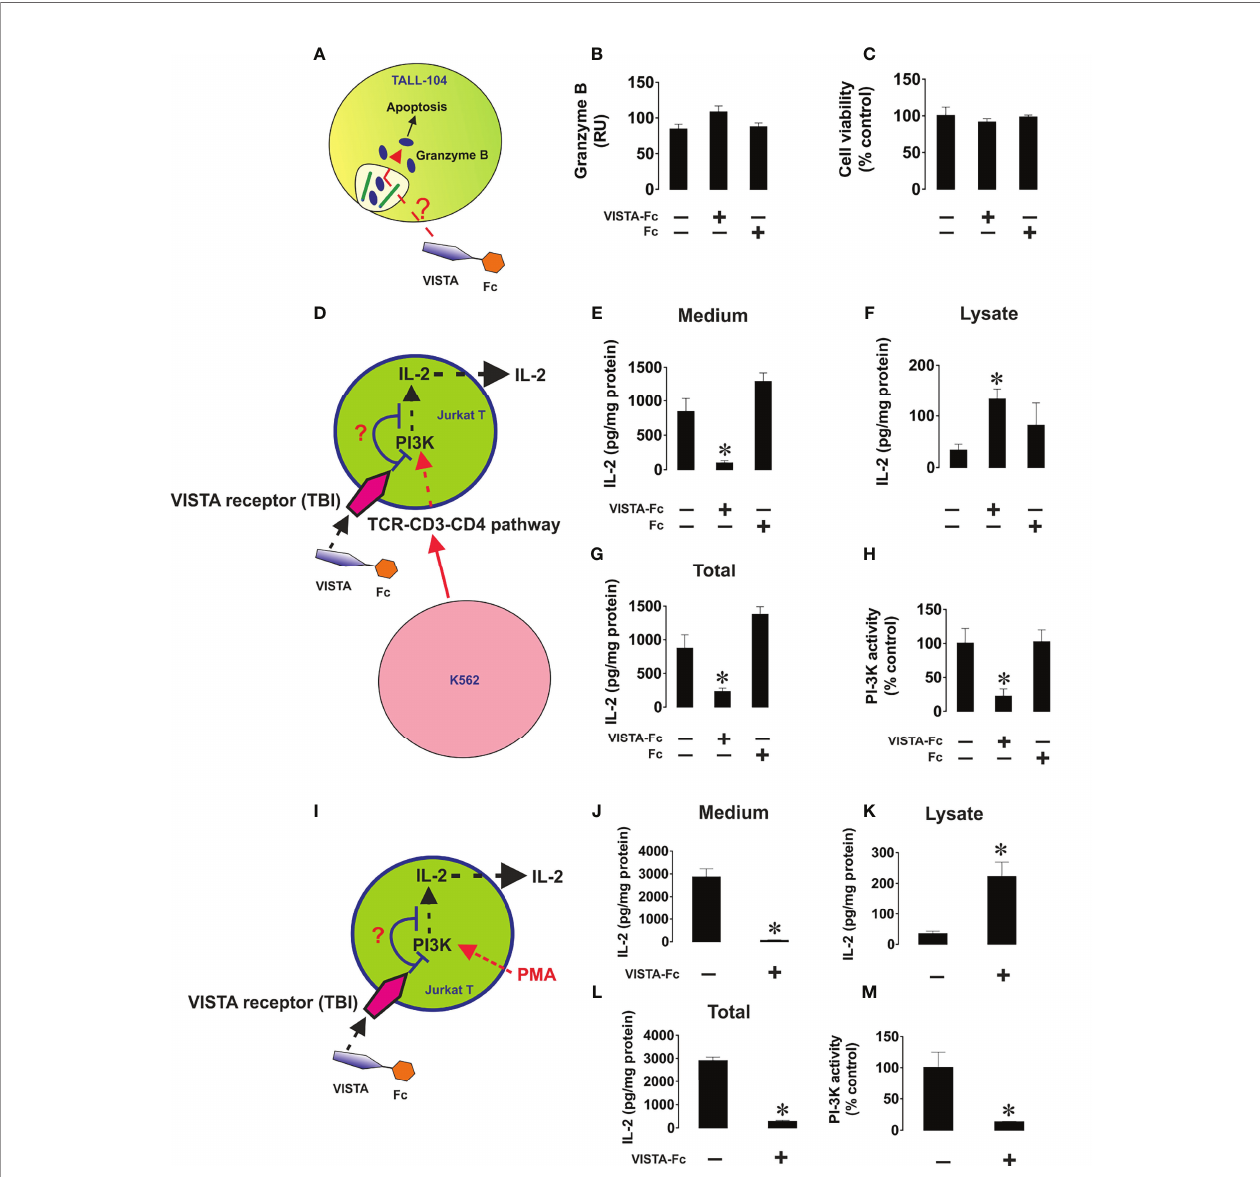
FIGURE 6 | Soluble VISTA does not induce intracellular activation of granzyme B in cytotoxic T cells and prevents the release of IL-2 from helper T cells. TALL-104 cells were exposed to either 5 µg/ml VISTA-Fc or an equimolar amount of Fc for 16 h (A) . In-cell activity of granzyme B (B) and viability of TALL-104 cells were then analyzed (C) . K562 chronic myeloid leukemia cells, which express traces and do not release detectable amounts of VISTA or IL-2 (as con fi rmed by ELISA), were used as targets. K562 cells were exposed to 100 nM PMA for 24 h in 96 well Maxisorp plates for immobilization. These cells were then co-cultured with Jurkat T cells (helper T cells) at the ratio 1: 1 (D) . Some of the wells containing Jurkat T cells were supplied with 5 µg/ml VISTA-Fc or an equimolar amount of Fc. Cells were then co-cultured for 24 h before separation. IL-2 was measured in the medium (E) and cell lysates (F) by ELISA. Total amounts of IL-2 were also calculated (G) . PI3K activity was measured as outlined in Materials and Methods (H) . To con fi rm the effects observed we exposed Jurkat T cells to 100 nM PMA for 24 h in the absence or presence of VISTA-Fc (I) . IL-2 was then measured in the medium (J) and cell lysates (K) by ELISA. Total amounts of IL-2 were also calculated (L) and PI3K activity assessed (M) . Data are shown as mean values ± SEM for 4 independent experiments. *p < 0.05 vs